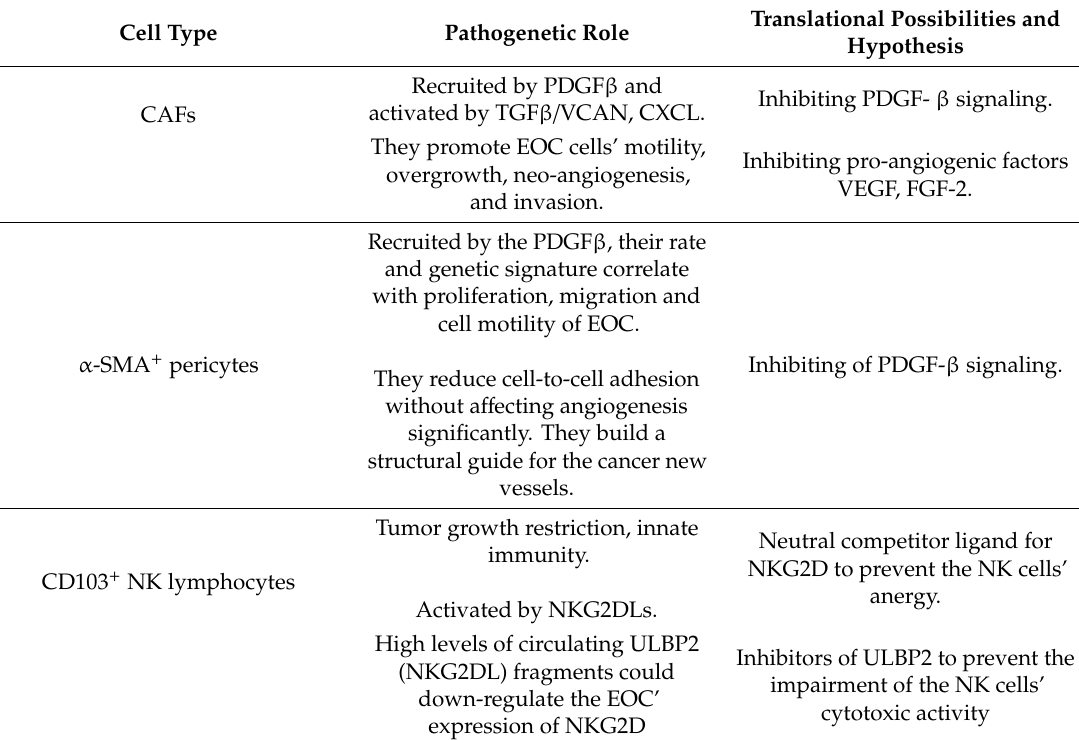
Table 1. Main cell types of the Epithelial Ovarian Cancer’s (EOC) TEM, their principal role in EOC pathogenesis and the possible translational